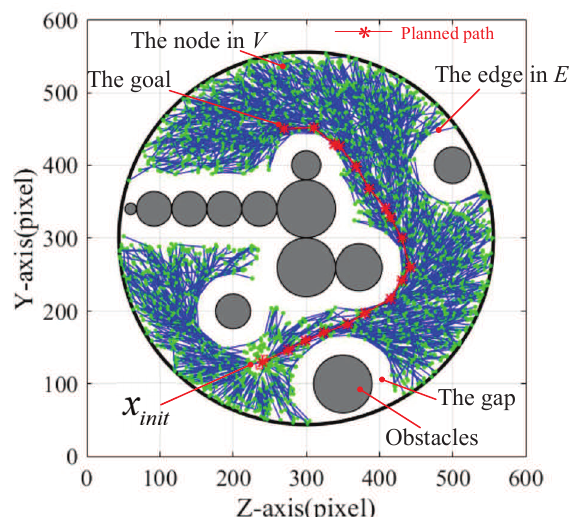
Figure 11. The planned path by RRT*. The red line denotes the planned sub-optimal